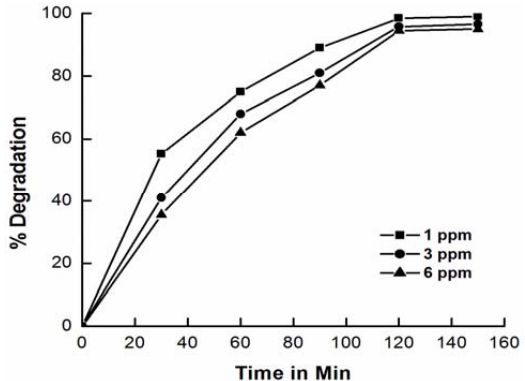
Fig. 6. Caffeine photocatalytic degradation with the variation Fig. 7. Caffeine photocatalytic degradation with the variation Fig. 6 Caffeine photocatalytic degradation with the variation in the feed concentration in the feed concentration of catalyst Fig.7. Caffeine photocatalytic degradation with the variation of catalyst load